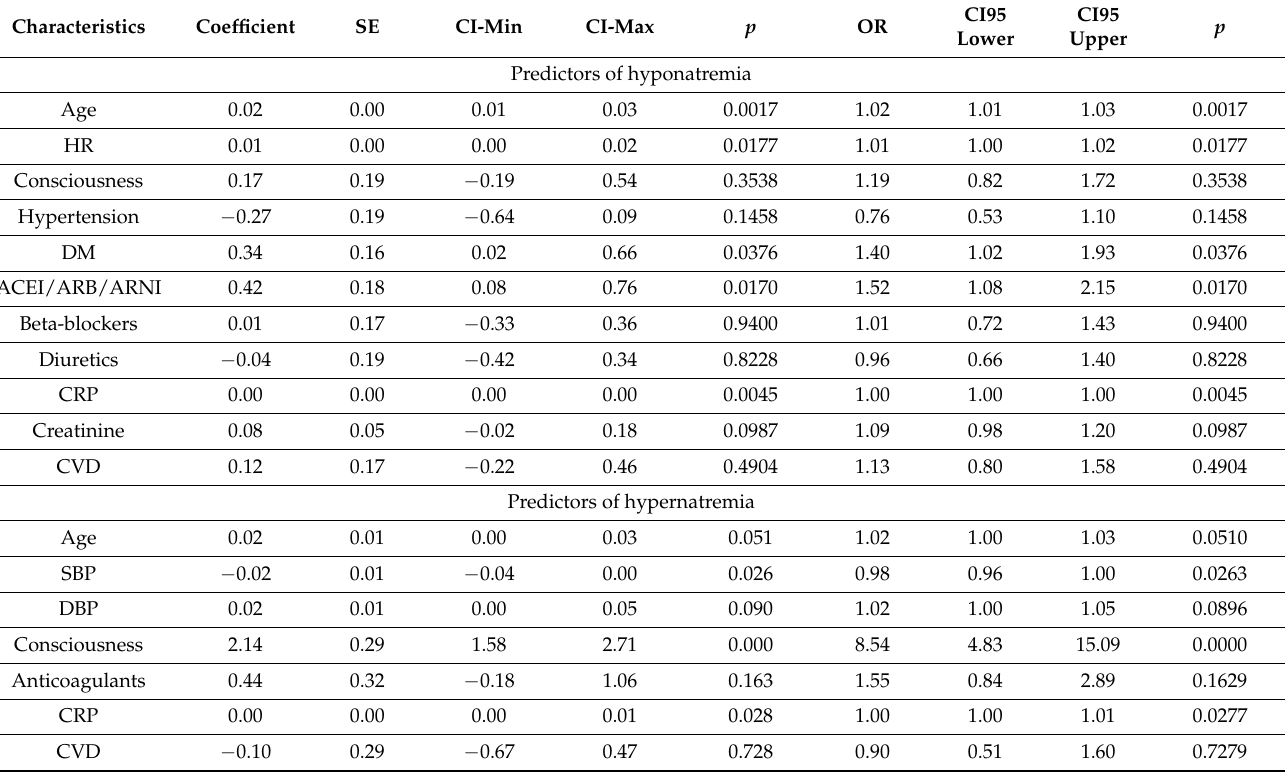
Table 5. Results of multivariate analyses, possible predictors of hyponatremia and hypernatremia.